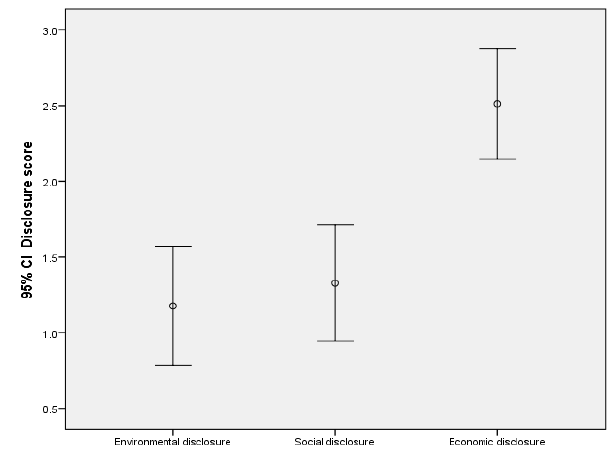
Figure 2: Confidence